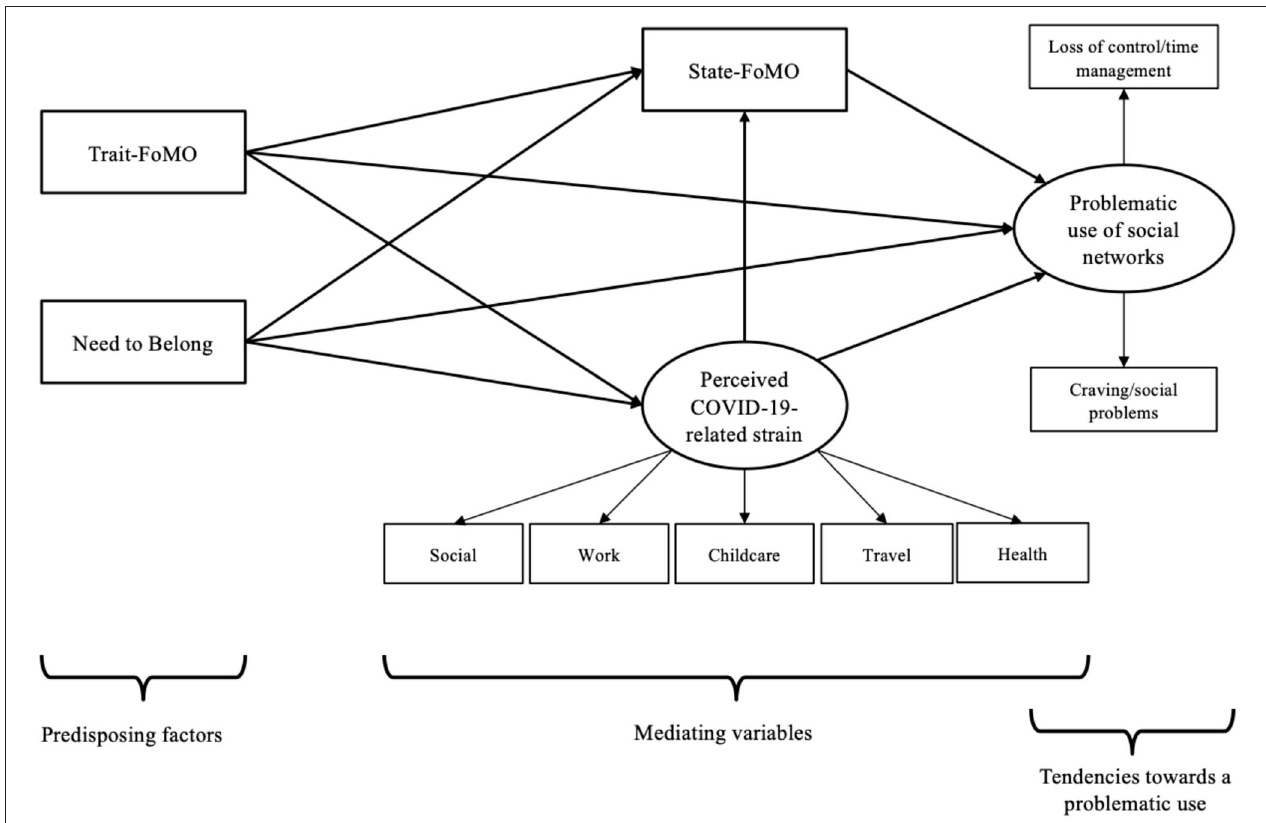
FIGURE 1 | The hypothesized model for analyzing the suggested direct and indirect effects including the latent dimensions of perceived strain due to COVID-19 related restrictions and problematic use of social networks. The figure shows the predisposing factors, the mediator variables, and the dependent variable. The directions of the hypothesized effects are illustrated by the arrows, which also symbolize the direct effects. The rectangles represent the manifest variables, depicted by the subscales of the questionnaires used. The ellipses illustrate the latent dimensions, which are created by the specific manifest